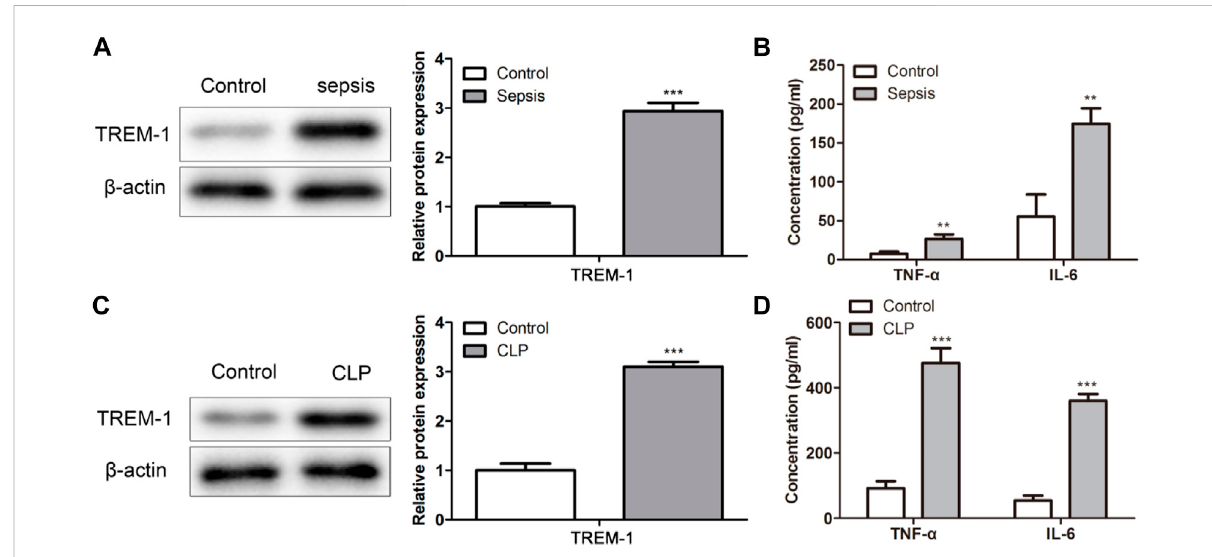
FIGURE 6 TREM-1 was highly expressed in bacterial-induced sepsis in vitro . (A,C) The TREM-1 expression level in sepsis was evaluated in sepsis patients and mice. (B,D) The levels of TNF- α and IL-6 were assessed in sepsis patients and mice. ** p < 0.01, *** p < 0.001 vs . Control.